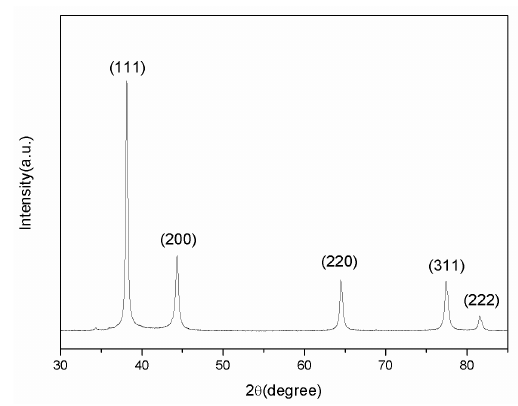
Figure 7. XRD pattern of Ag powder samples.